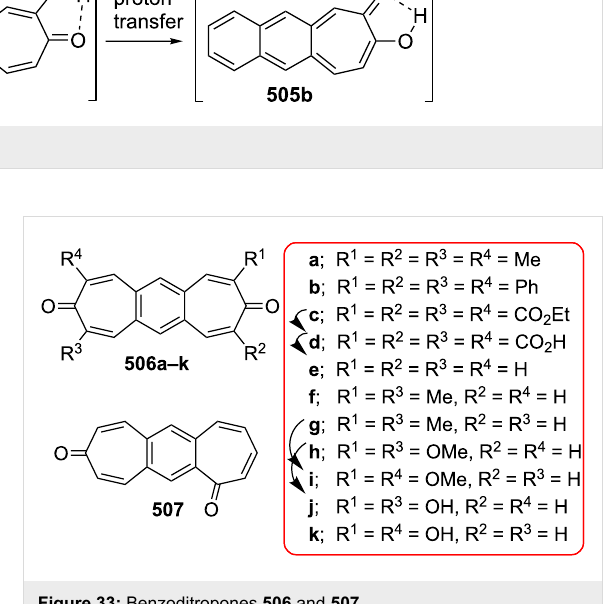
Figure 33: Benzoditropones 506 and 507